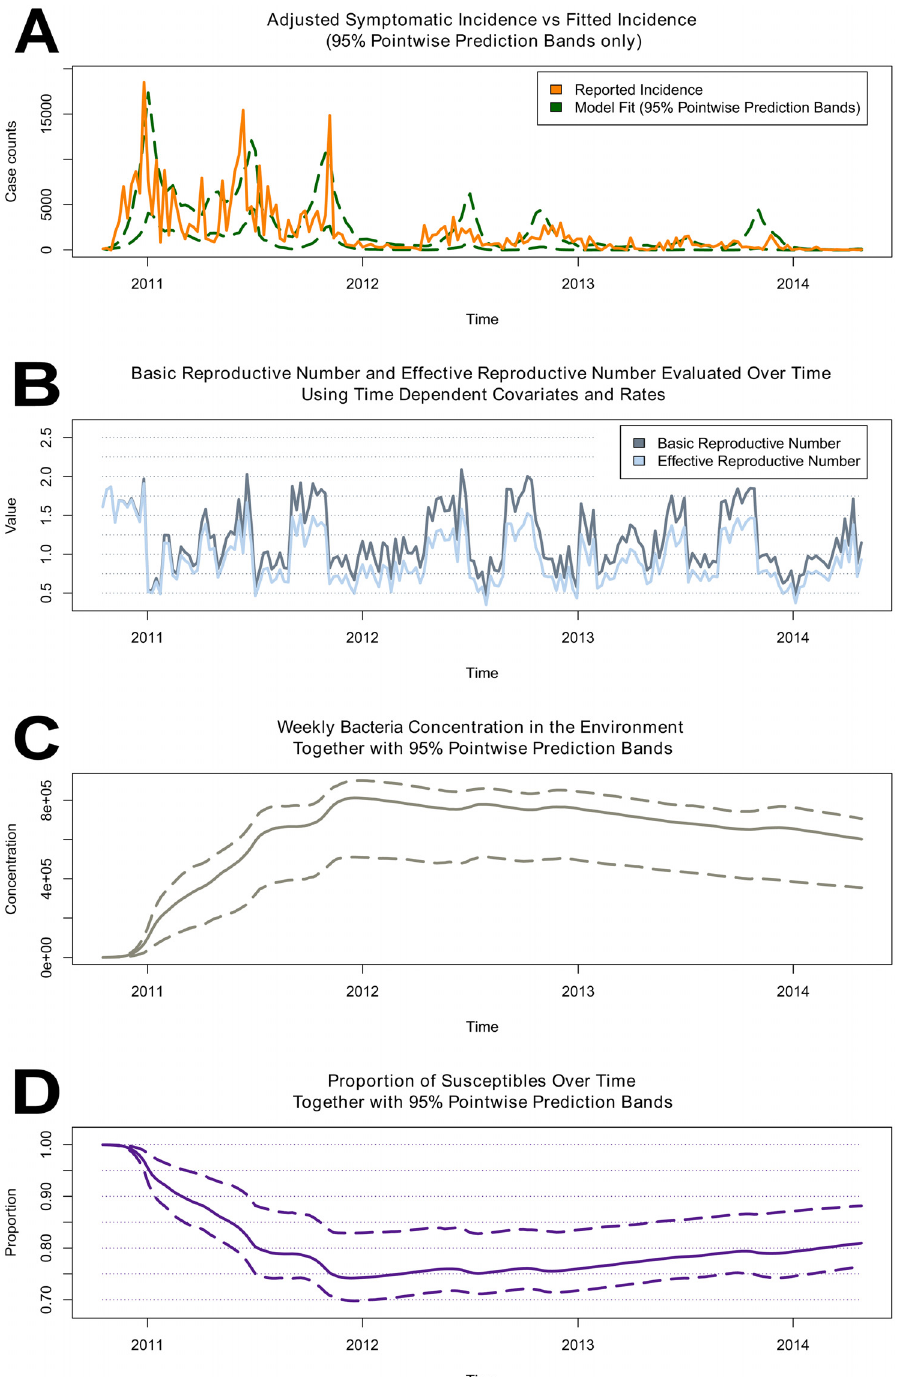
Fig 4. The behavior of the epidemic over time. A) Pointwise prediction bands for the symptomatic infections produced by the model. B) The change in the value of the estimated basic reproductive number ^ R ð t Þ (using extended de fi nition) and in the value of the estimated effective reproductive number ^ R ð t Þ over 0 time. C) V. cholerae concentration in the environment over time and the corresponding prediction bands. D) Change in the proportion of the susceptible individuals during the course of the epidemic produced by the model and the corresponding prediction